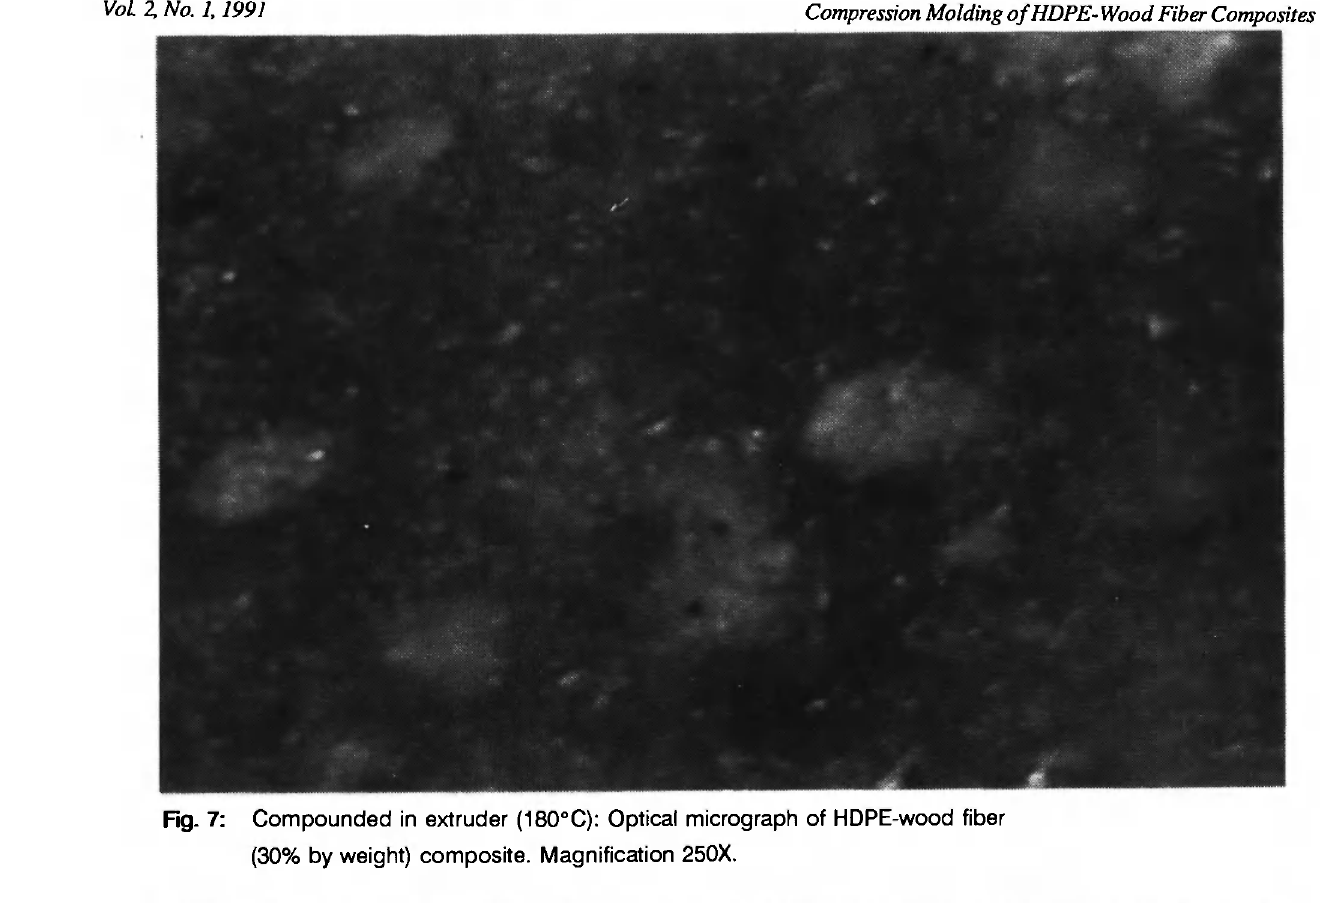
Fig. 7: Compounded in extruder (180°C): Optical micrograph of HDPE-wood fiber (30% by weight) composite. Magnification 250X.